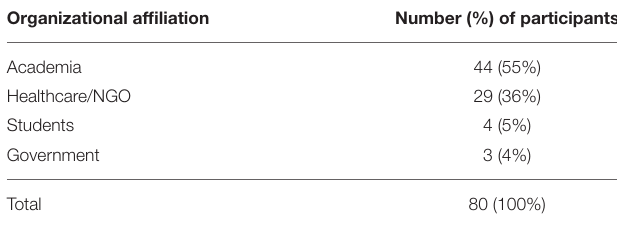
TABLE 1 | Distribution of participants by organization.